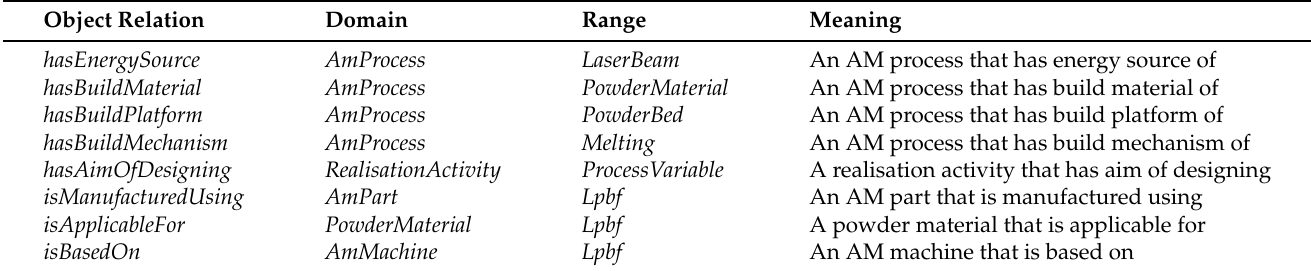
Table 3. Domain, range, and meaning of eight top-level object